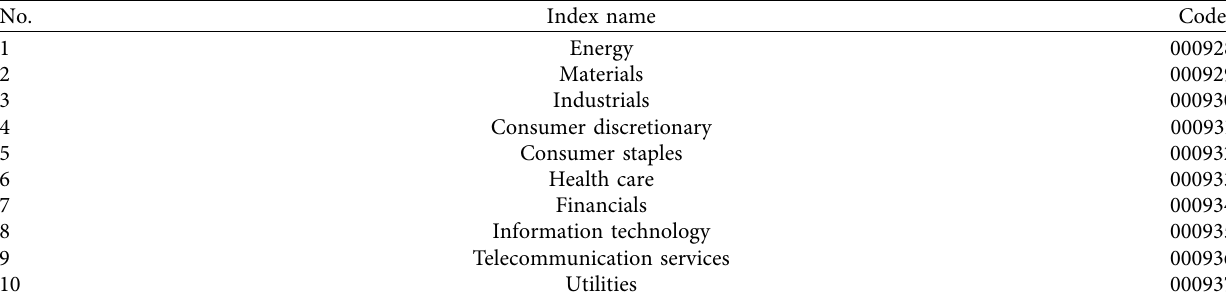
Table 1: The names and codes of 10 industry sector indexes.